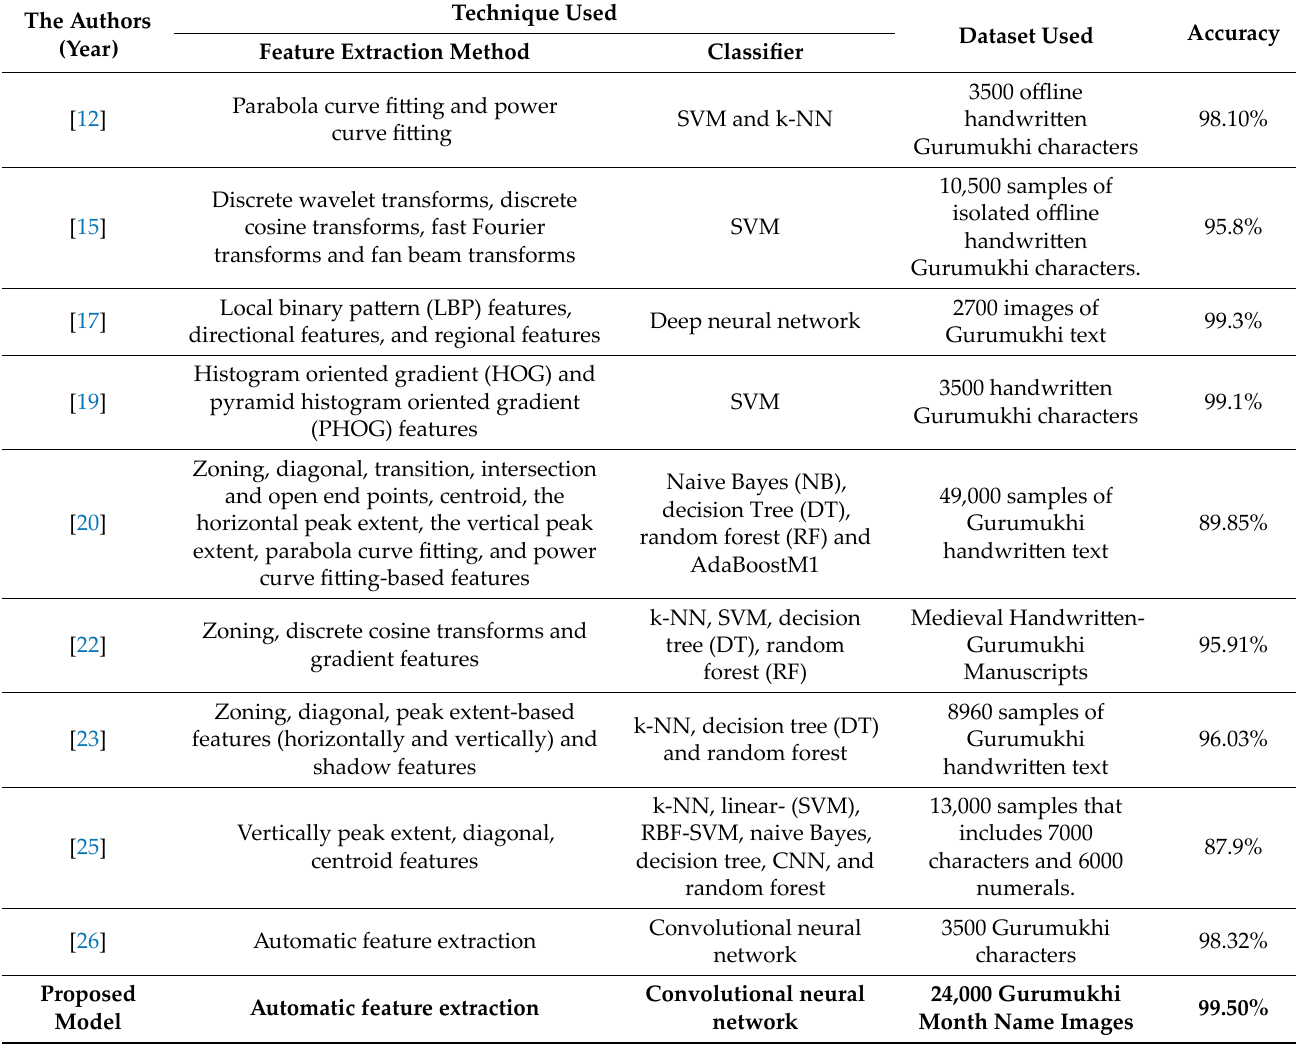
Table 5. Comparison of proposed model with existing text recognition